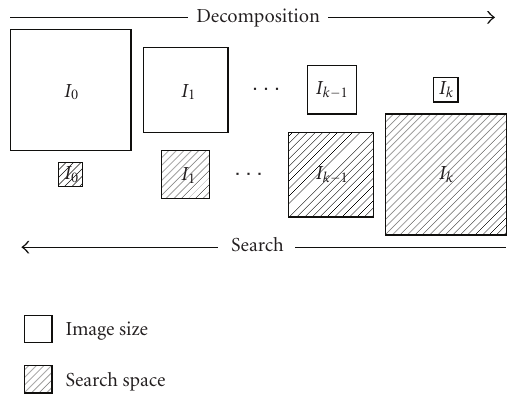
Figure 7: Decrease the search space and increase the search resolution in the search